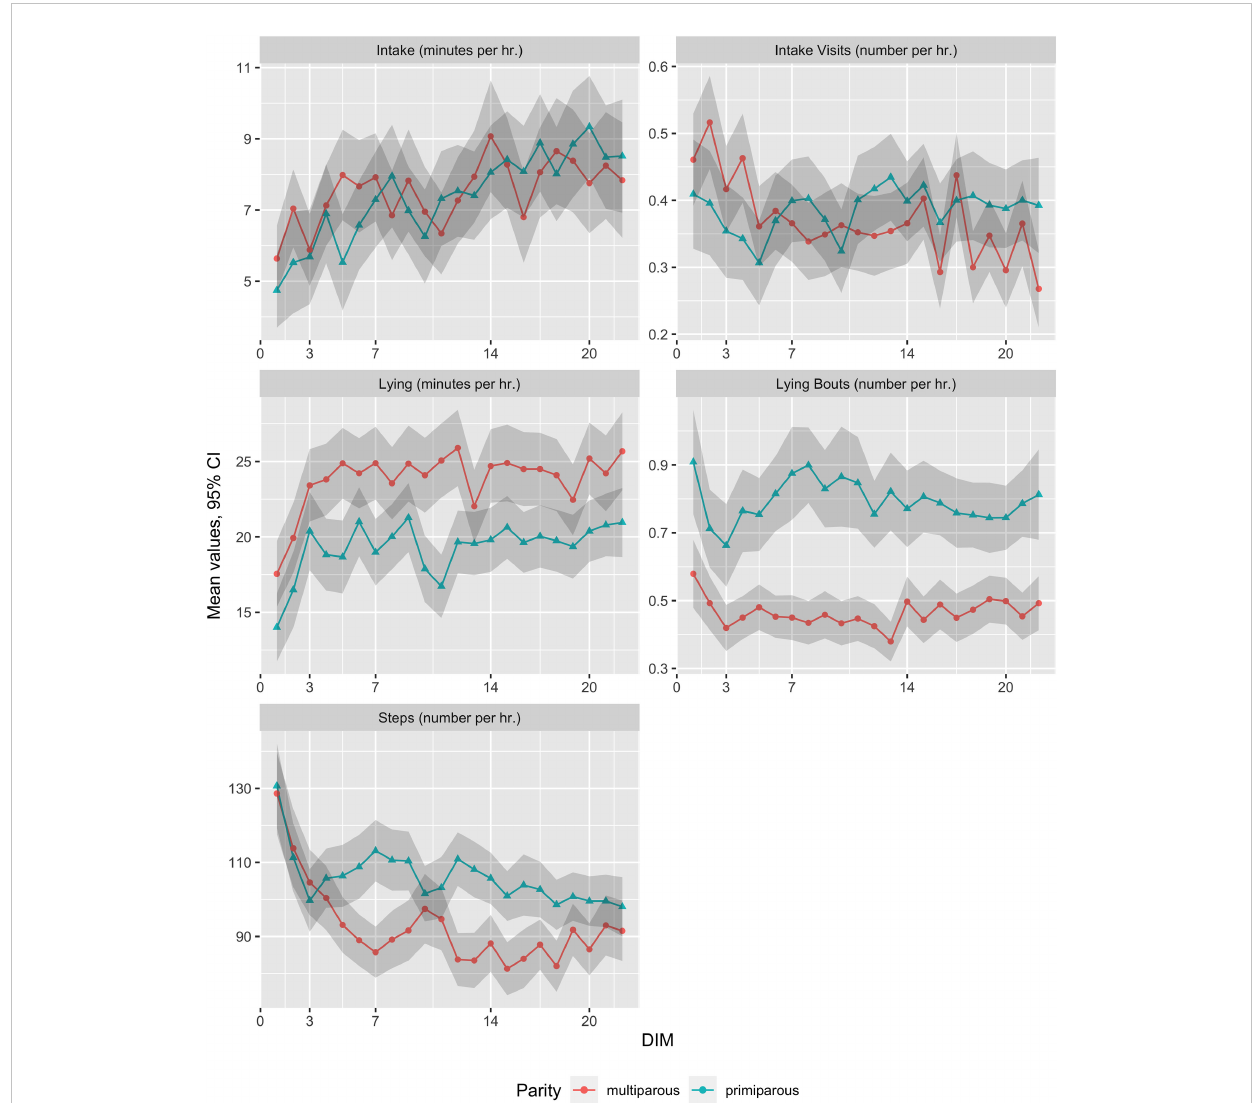
FIGURE 2 Mean raw sensor data and 95% C.I. for the mean by days in milk (DIM) strati fi ed by parity for the fi ve behavior variables measured with a leg-attached 3-axis accelerometer (TrackaCow, ENGS, Hampshire,